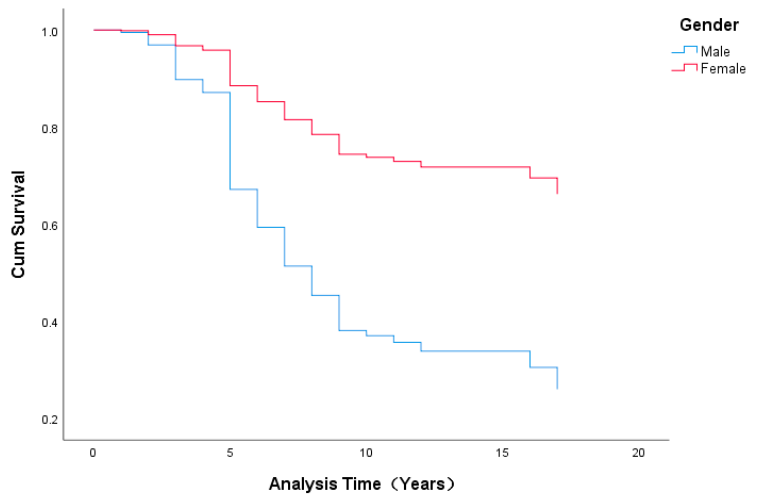
Figure 6. Survival Function for Gender in Promotion from Associate to Full Professor.